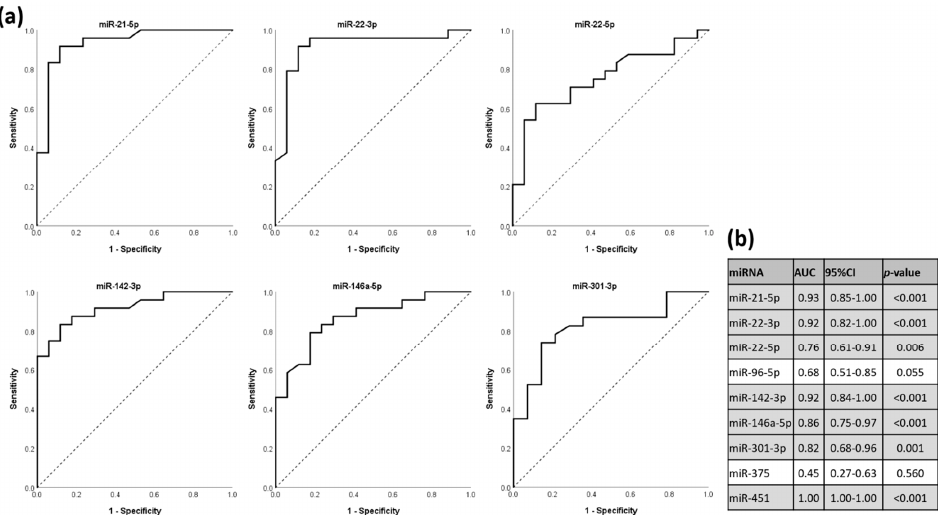
Figure 5. The potential of differentially expressed miRNAs to discriminate between HT status and healthy controls, shown in ROC curves. ( a ) ROC curves of selected differently expressed miRNAs. ( b ) Calculated AUC values, 95% CI and p -values of each investigated miRNA. ROC, receiver-operating characteristic; DE, differentially expressed; AUC, area under the curve; CI, confidence interval.